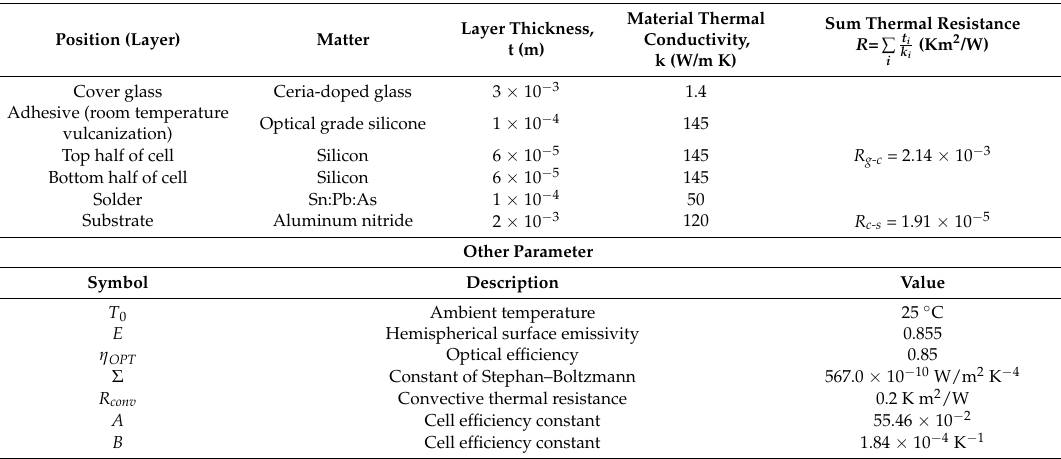
Table 1. Parameters used in the thermal cooling